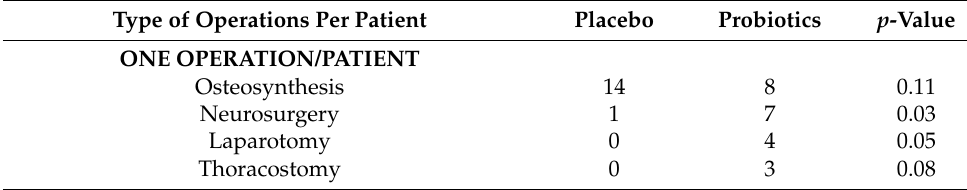
Table 3. The combination of operations performed per treatment